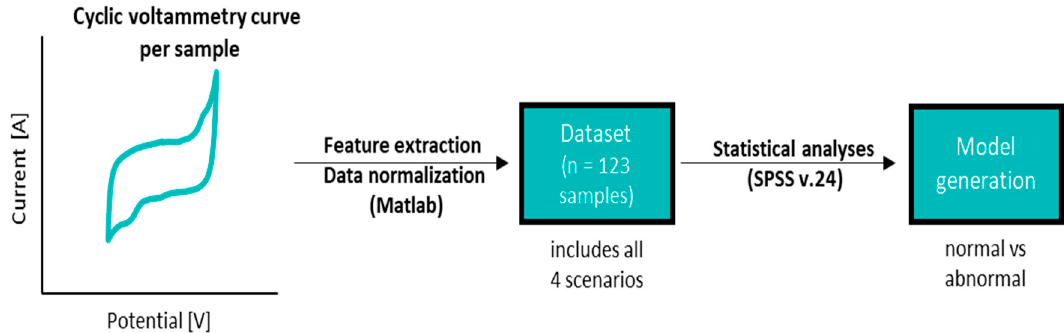
Figure 2. Description of the methodology followed in the manuscript.